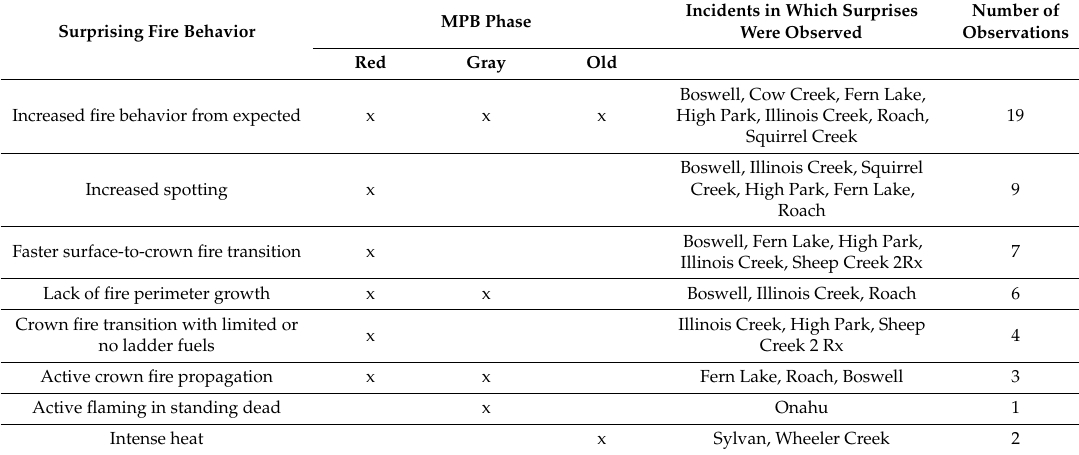
Table 3. Surprising fire behavior characteristics in post-mountain pine beetle outbreak fires by MPB